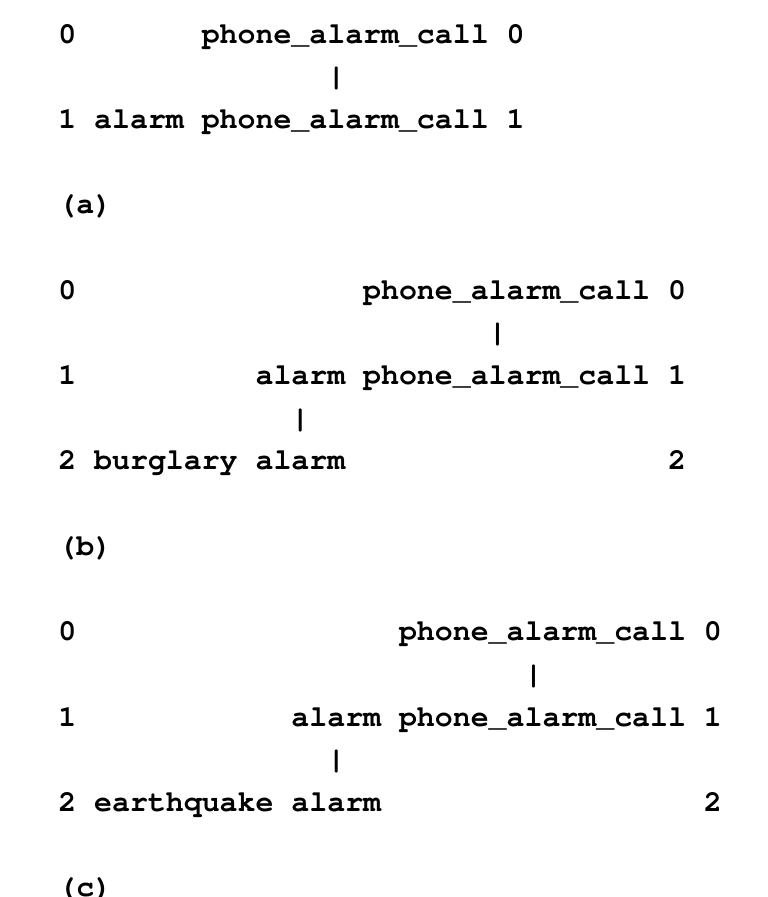
Figure 23. The best multiple alignment (at the top) and the other two multiple alignments in its reference set formed by the SP model with the pattern, “ phone alarm call ”, in New and the patterns from Figure 22 in Old. In order from the top, the values for CD with relative probabilities in brackets are: 19.91 (0.656), 18.91 (0.328) and 14.52 (0.016).